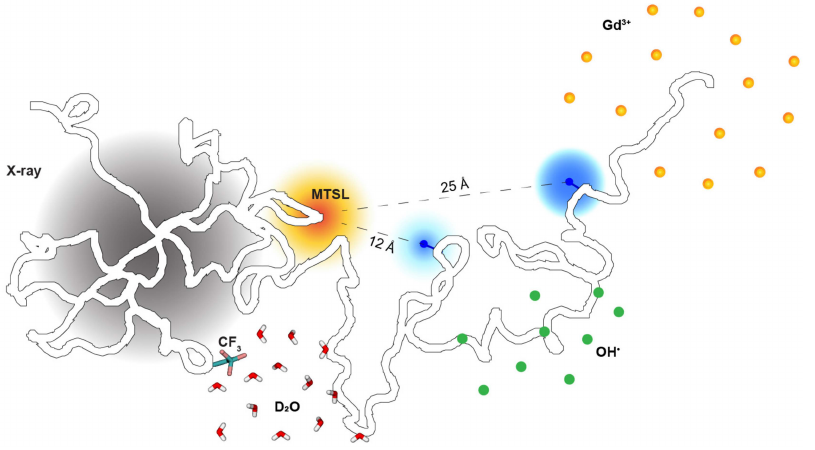
Figure 1. A schematic diagram of various biophysical techniques probing the structural properties of intrinsically disordered proteins (IDPs). A large gray circle illustrates the 2D pattern from small-angle X-ray scattering to provide information about the global conformation and the pairwise distance distribution between atoms within the protein. MTSL (large orange circle): a nitroxide spin label; blue dots: observed NMR-active nuclei whose signal intensity is attenuated (blue circles) to monitor specific distances from the paramagnetic spin-label, typically within the range of 12–25 Å. Gd 3+ represents gadodiamide. OH: hydroxyl radicals; CF 3 : a trifluoromethyl tag; D 2 O: heavy/deuterated water. These agents act as a probe to detect site-specific information about solvent accessibility at the peptide or single-residue